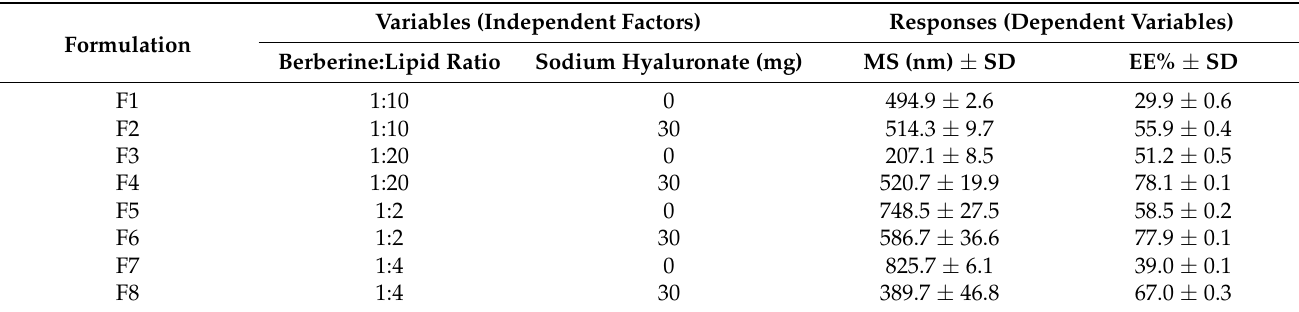
Table 1. Composition, mean size and % EE of various berberine loaded